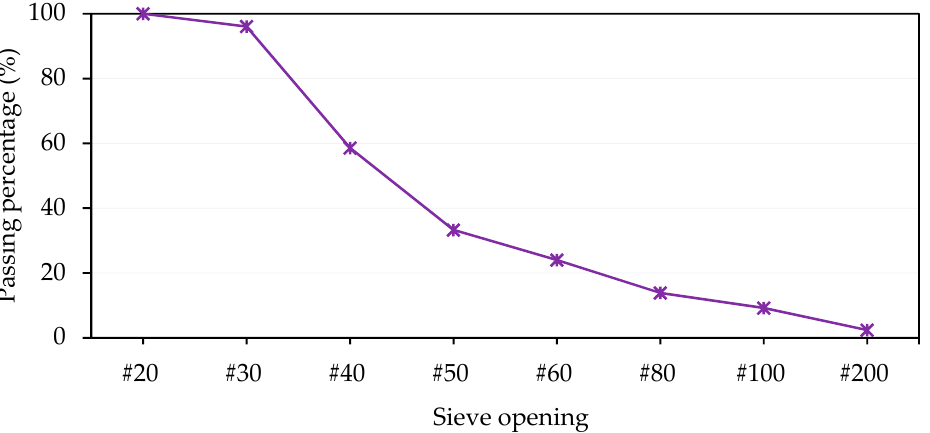
Figure 21. Gradation of crumb rubber modifier.